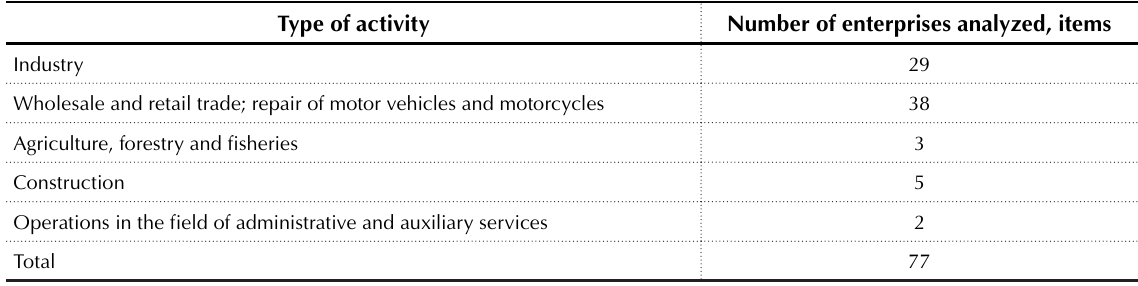
Table 9. Characteristics of the enterprises according to types of economic